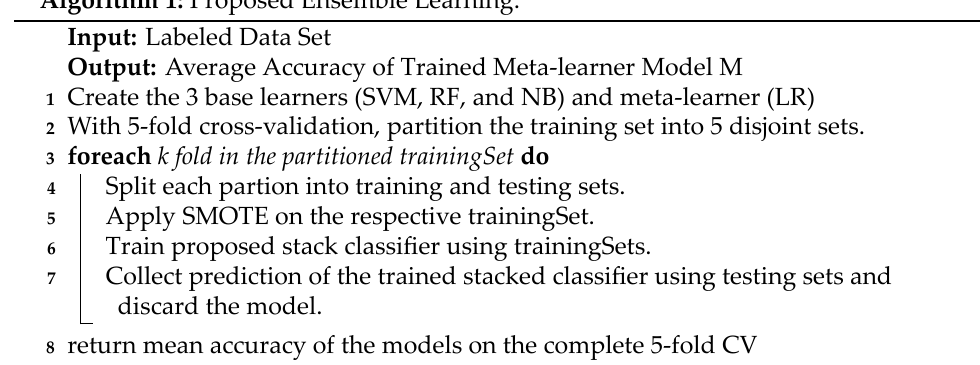
Algorithm 1: Proposed Ensemble